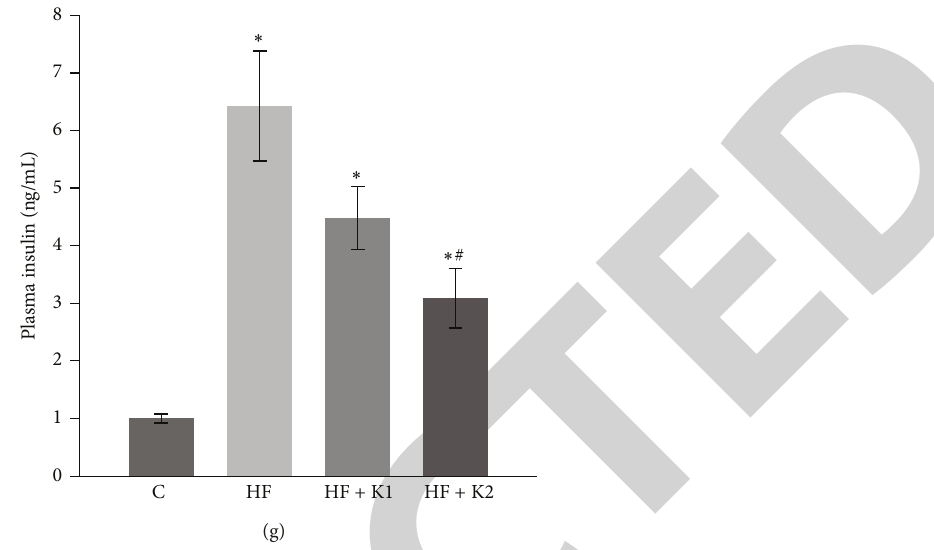
Figure 2: Kaempferol supplementation reduced blood glucose, HbA1c, and insulin concentrations and improved insulin sensitivity in HF diet-fed mice. (a) Fasting blood glucose levels were measured at indicated time points of dietary treatment. GTT (b) and ITT (d) were performed as described in Section 2. The area under the curve (AUC) for GTT (c) and ITT (e) was calculated. (f) Plasma insulin levels were measured using an ELISA kit. Data are shown as means ± SE ( 𝑛 = 12 ). ∗ 𝑝 < 0.05 versus SD-fed mice (C); # 𝑝 < 0.05 versus HF-fed mice. C: standard diet; HF: high-fat diet; HF + K1: HF diet containing 0.01% kaempferol; HF + K2: HF diet supplemented with 0.05%